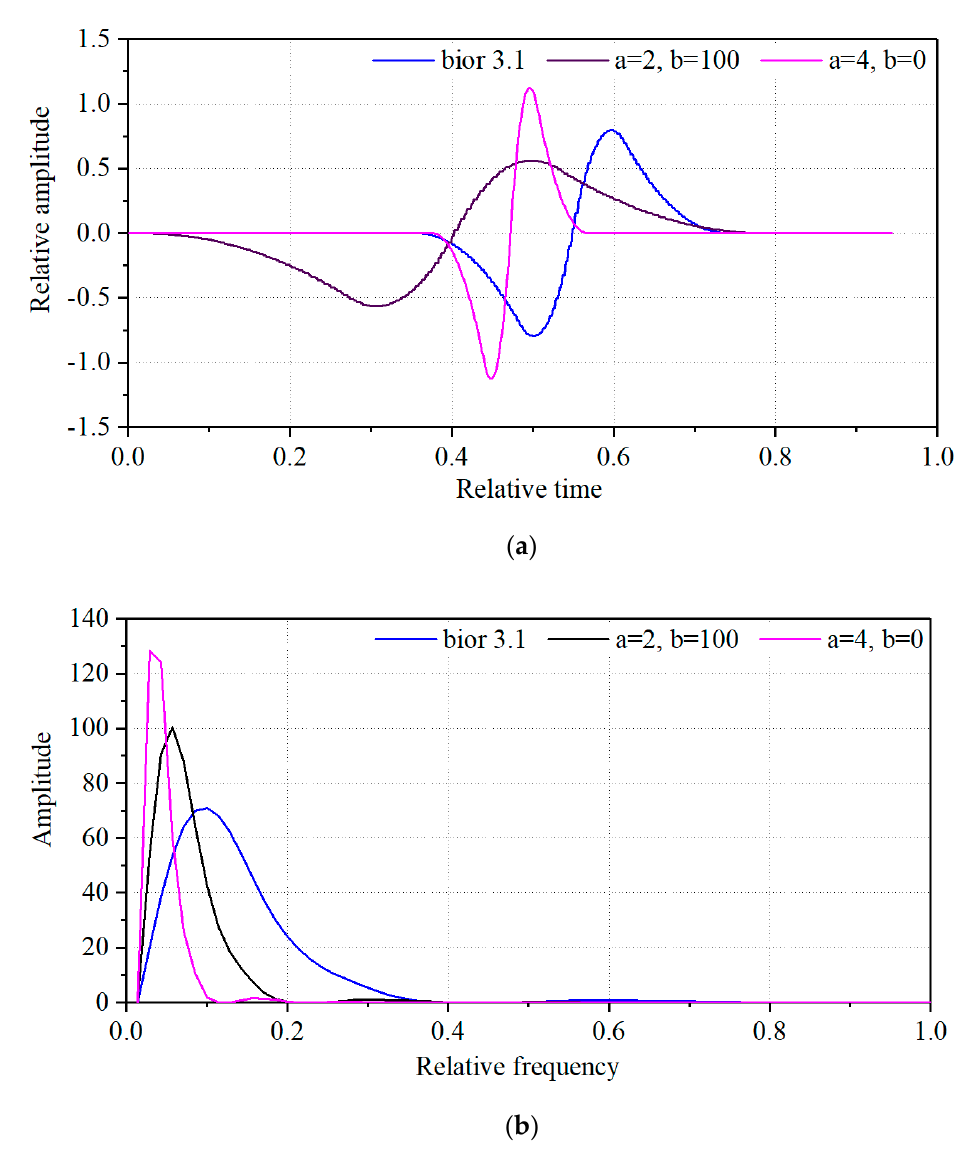
Figure 6. Dilation and translation of a mother wavelet . ( a ) time domain; ( b ) frequency domain.